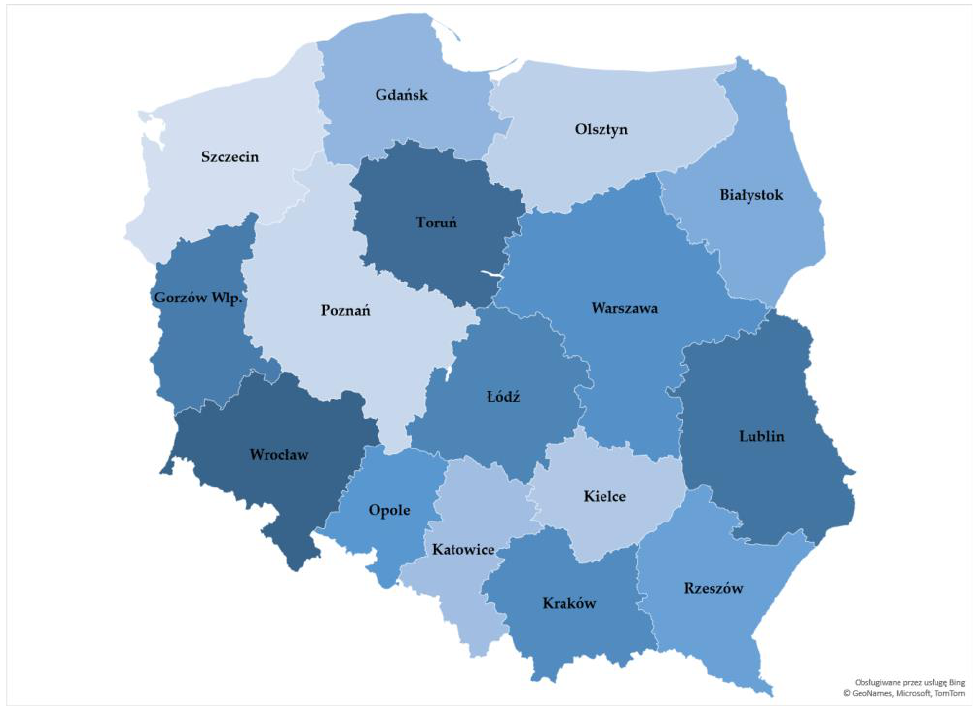
Figure 1. The localization of studied cities.